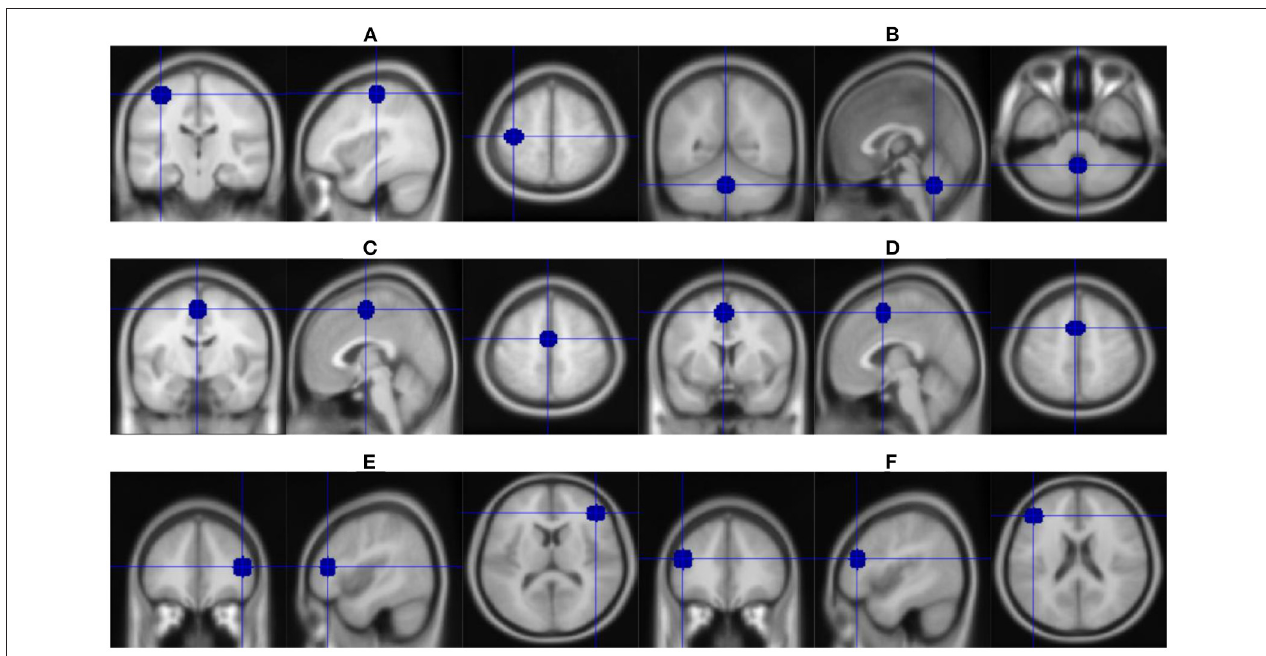
FIGURE 3 | Overview of stimulation brain regions in studies mentioned in Tables 1 , 2 . (A) Left motor cortex. (B) Cerebellum. (C) Supplementary motor area. (D) Pre-supplementary motor area. (E) Right inferior frontal cortex. (F) Left dorsolateral prefrontal cortex.